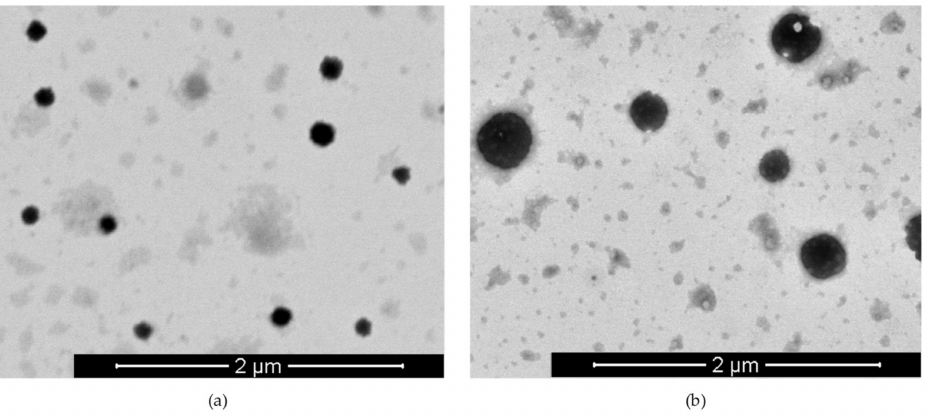
Figure 2. Scanning Transmission Electron Microscopy (STEM) images of blank chitosan nanocapsules (CSNCs) ( a ) and OVA-loaded CSNCs ( b ).